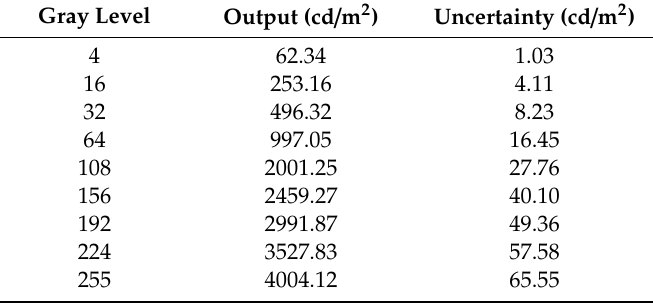
Table 6. Luminance and standard uncertainty corresponding to some typical gray